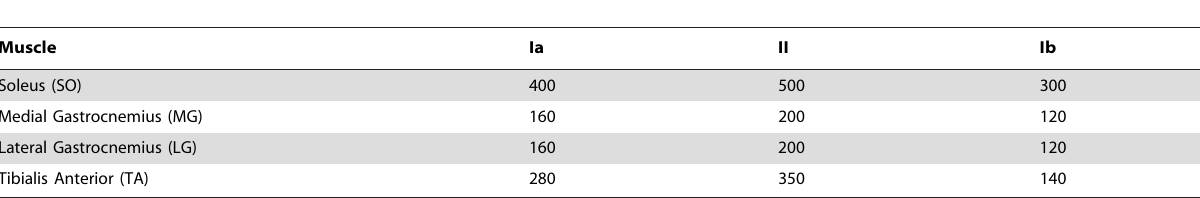
Table 5. Number and types of afferent fibres adopted for each muscle represented in the model.